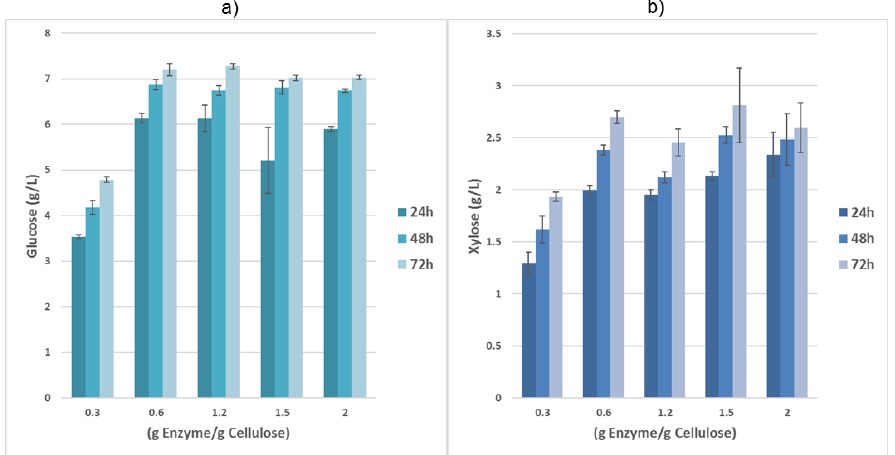
Figure 1. Enzymatic hydrolysis of pretreated chestnut shells with Cellic Ctec2. The reaction was conducted with a 5% ( w/v ) biomass load. Glucose ( a ) and xylose ( b ) release over time. The obtained hydrolysis efficiencies are indicated in Table 1.